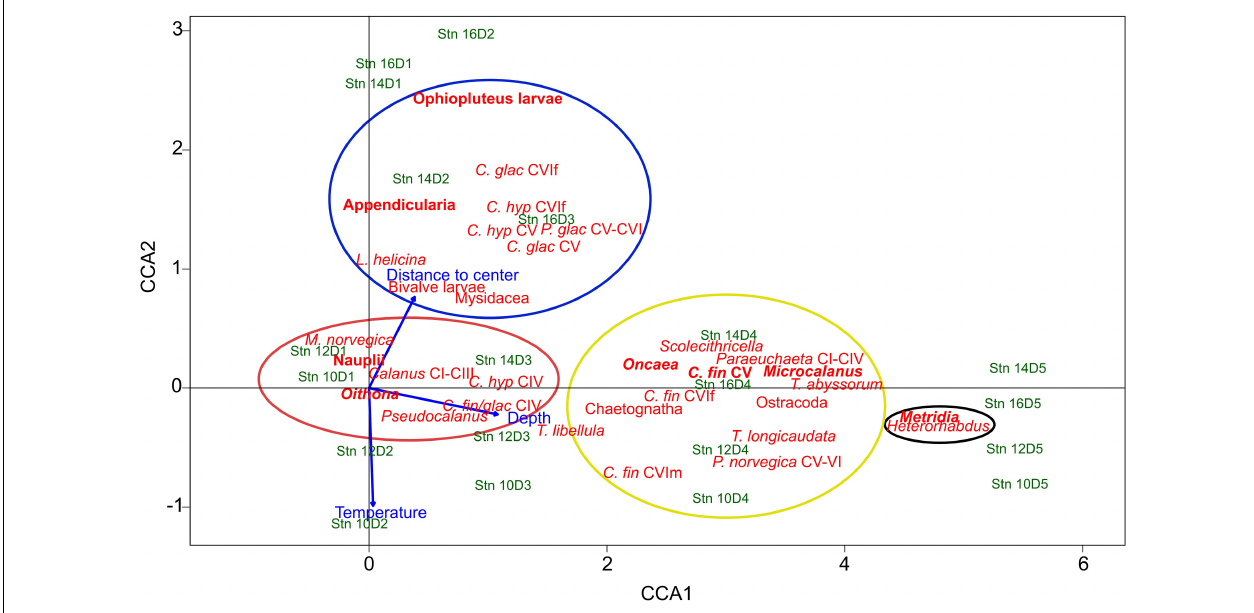
FIGURE 4 | Canonical correspondence analysis (CCA) triplot of the most common zooplankton taxa, environmental variables (depth, temperature, and distance to the filament center) and individual depth-stratified samples across the submesoscale filament. Stn: Station. D1–D5 indicate depth intervals, D1: 0–10 m, D2: 10–50 m, D3: 50–100 m, D4: 100–200 m, D5: 200–300 m. The first axis (CCA1) explains 60%, the second axis (CCA2) explains 4% of the total variance. Colored circles indicate the association of taxa with the four distribution types, red: convergence and concentration of surface inhabitants close to the filament center, blue: polar taxa at outer stations, black: emergence of mesopelagic taxa beneath the filament, yellow: mesopelagic taxa, including travelers with along-frontal jets. Indicated in bold are the main contributors of respective distribution types. Species abbreviations: C. glac , Calanus glacialis ; C. hyp , Calanus hyperboreus ; C. fin , Calanus finmarchicus ; P. glac , Paraeuchaeta glacialis ; P. norvegica , Paraeuchaeta norvegica ; M. norvegica , Microsetella norvegica ; T. libellula , Themisto libellula ; T. abyssorum , Themisto abyssorum ; T. longicaudata , Thysanoessa longicaudata ; L. helicina , Limacina helicina . CI to CVI, copepodite stage; f, female; m,